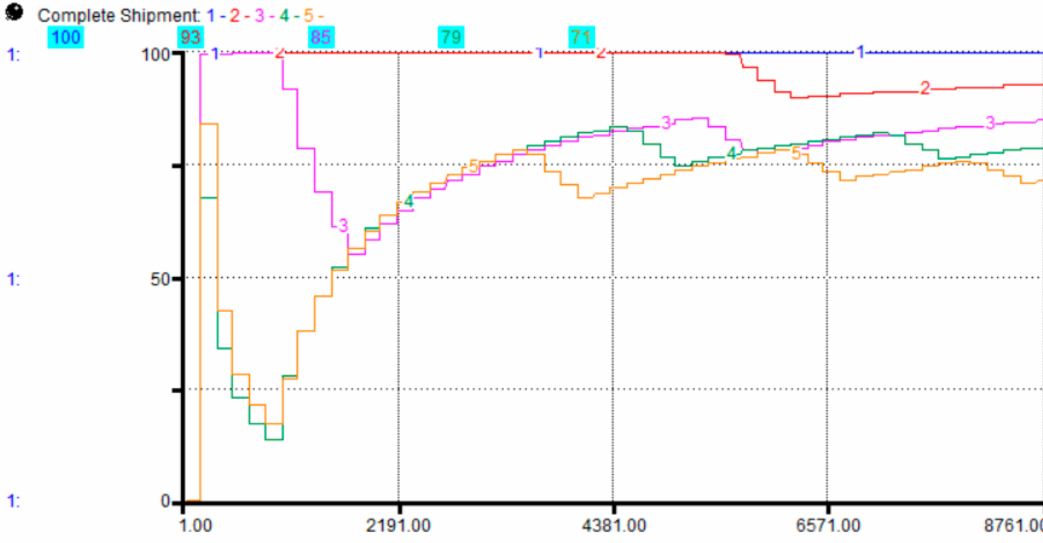
Figure 8. Complete Shipment in the five scenarios.